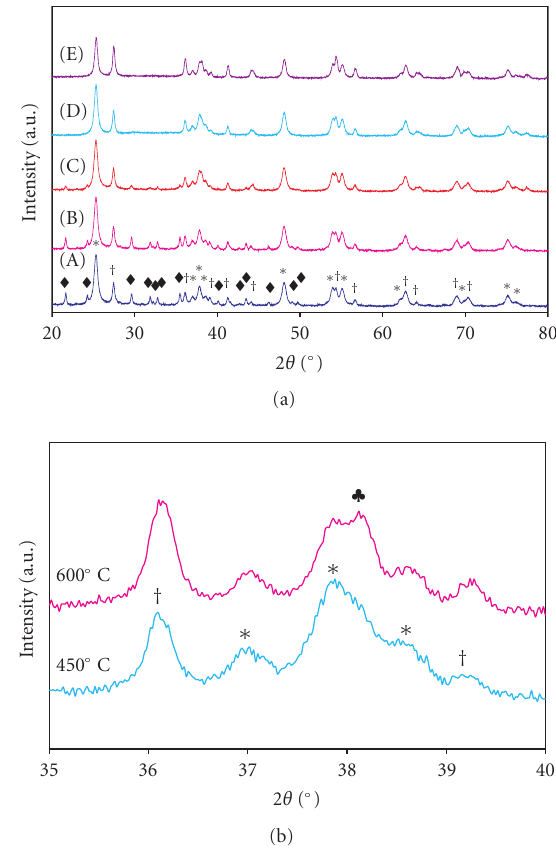
Figure 1: (a) Powder XRD di ff ractograms for 5 wt.% Ag-TiO 2 pho- tocatalysts calcined at 70 ◦ C (A), 120 ◦ C (B), 200 ◦ C (C), 450 ◦ C (D), and 600 ◦ C (E). (b) Enlarged section of (a) showing metallic silver di ff ractions. Reflections due to anatase, rutile, silver nitrate, and sil- ver are indicated by the symbols ∗ and † , ♦ , and ♣ , respectively.